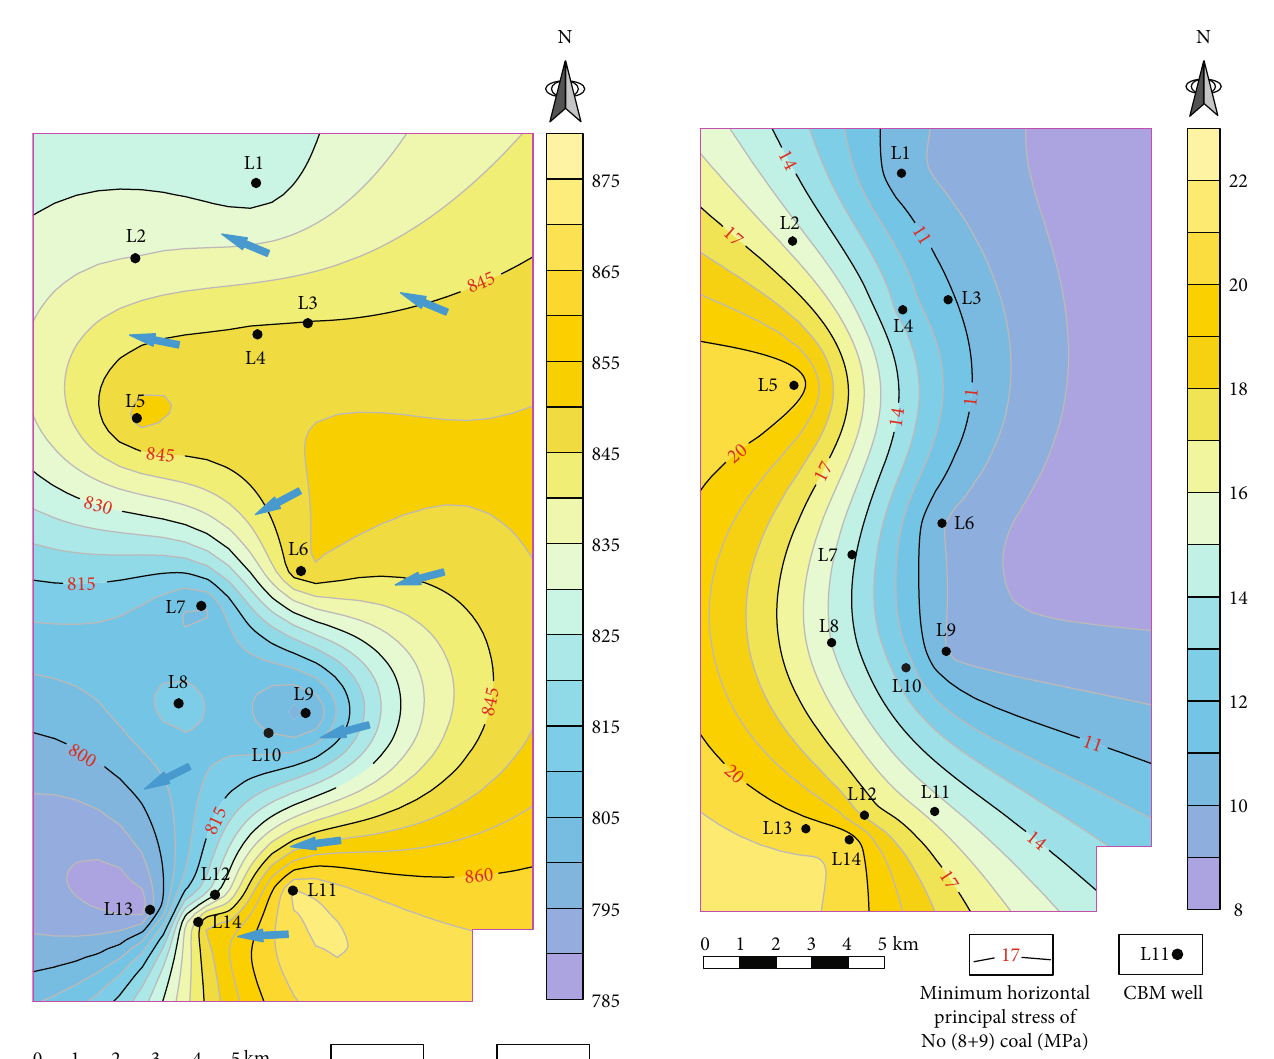
Figure 9: Contour map of minimum horizontal principal stress of No. ( 8 + 9 ) coal in Yangjiapo